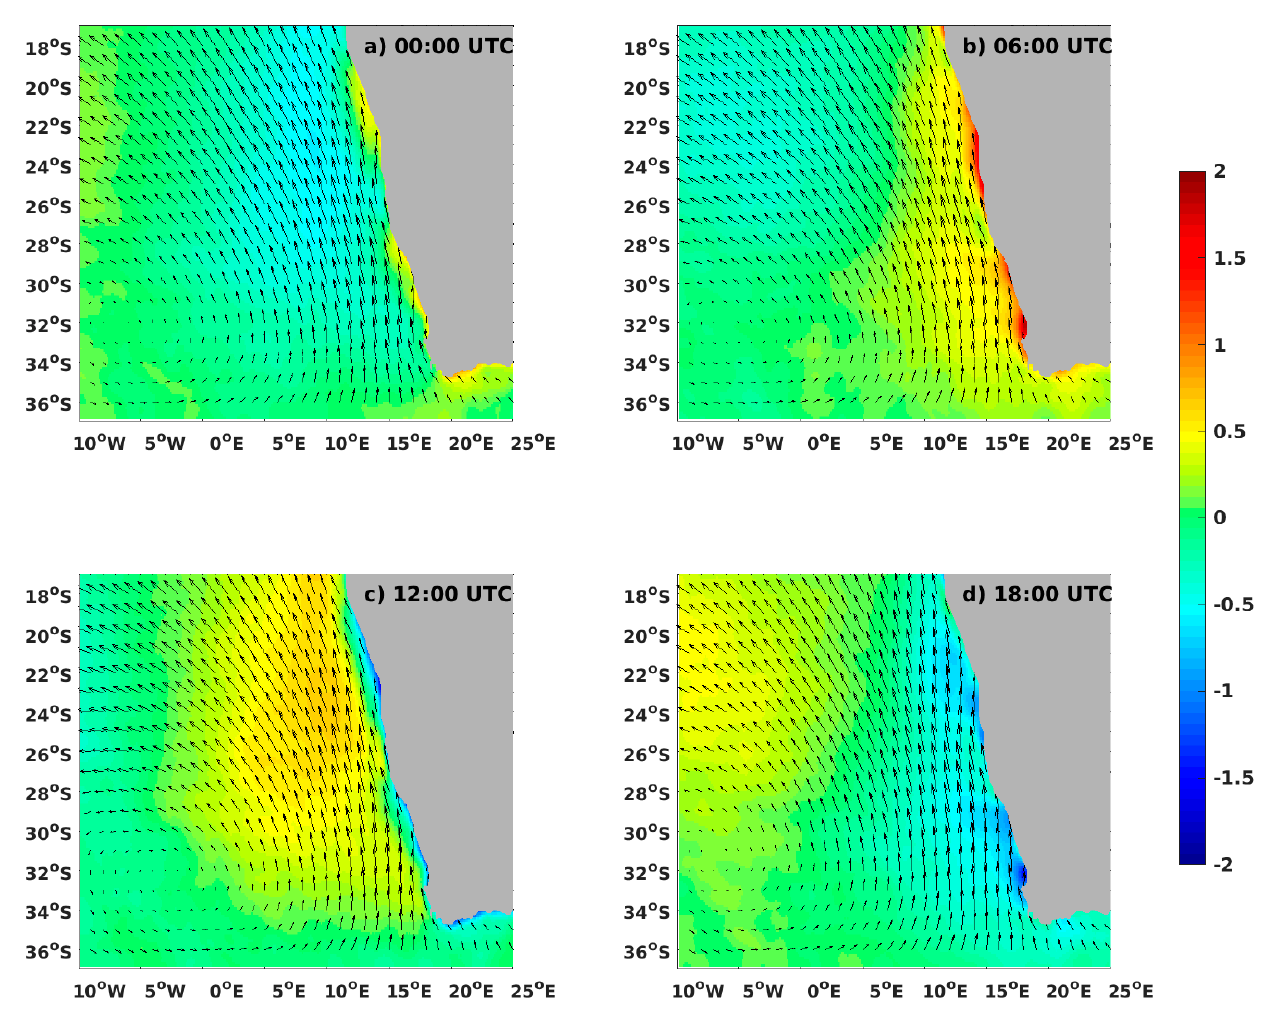
Figure 11. The same as in Figure 10 but for the Benguela region in